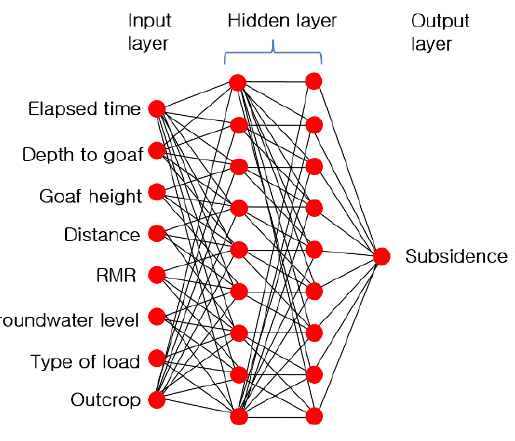
Figure 10. Analyzed optimum structure.